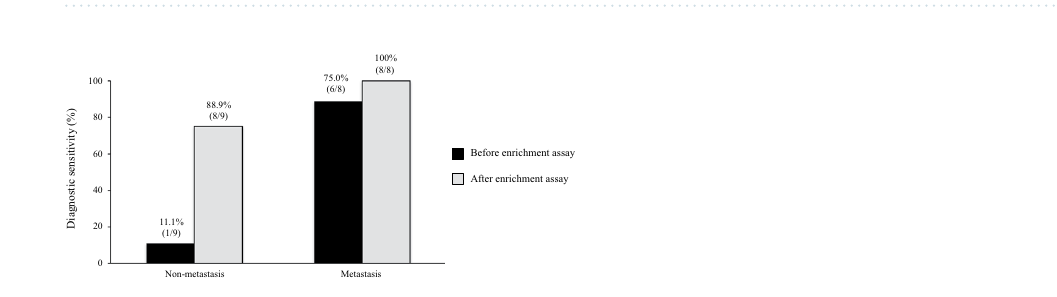
Table 3. Concordance between tumor-tissue analysis and ctDNA analysis. a P < 0.05 vs. before enrichment assay. b No significant difference compared with before enrichment assay.